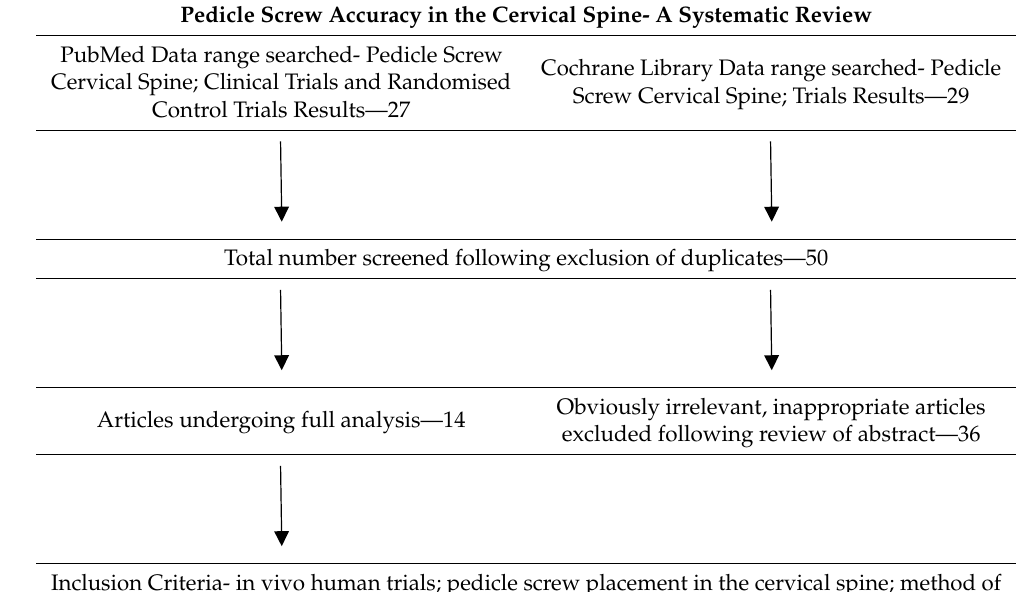
Table 1. PRISMA diagram outlining how the systematic review was conducted.